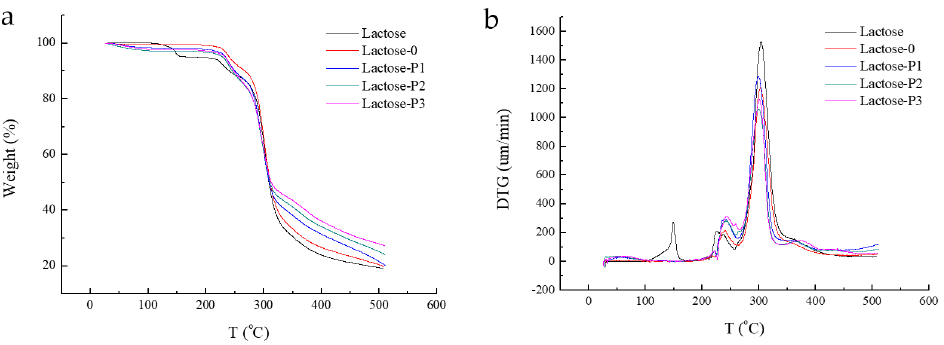
Figure 4. The ( a ) TG and ( b ) DTG analysis of materials. Lactose, the raw material; Lactose-0, pro- cessed without PVP K30; Lactose-P1, processed with 1% PVP K30; Lactose-P2, processed with 2% PVP K30; Lactose-P3, processed with 3% PVP K30.